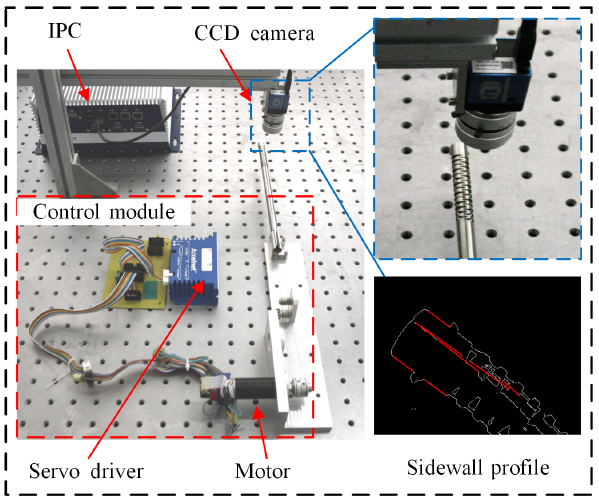
Figure 8. Experiment platform for the hysteresis model of the notched continuum manipulator.